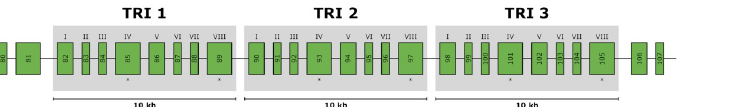
Fig 1. A schematic of the exons in the NEB TRI region. The exons targeted by the ddPCR assays are marked with an asterisk ( �